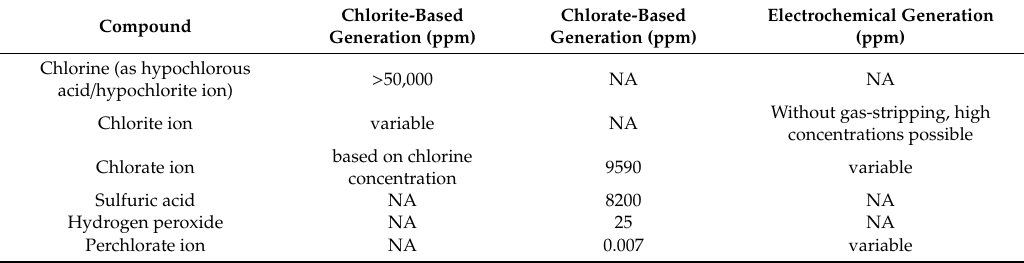
Table 16. Expected product constituents for non-optimized chlorine dioxide generators, per 1000 ppm chlorine dioxide generated. Adapted from [308]. Used with permission of John Wiley & Sons. Chlorite-Based Chlorate-Based Electrochemical Generation Compound Generation (ppm) Generation (ppm) (ppm) Chlorine (as hypochlorous NA NA acid / hypochlorite ion) Without gas-stripping, high Chlorite ion NA concentrations possible